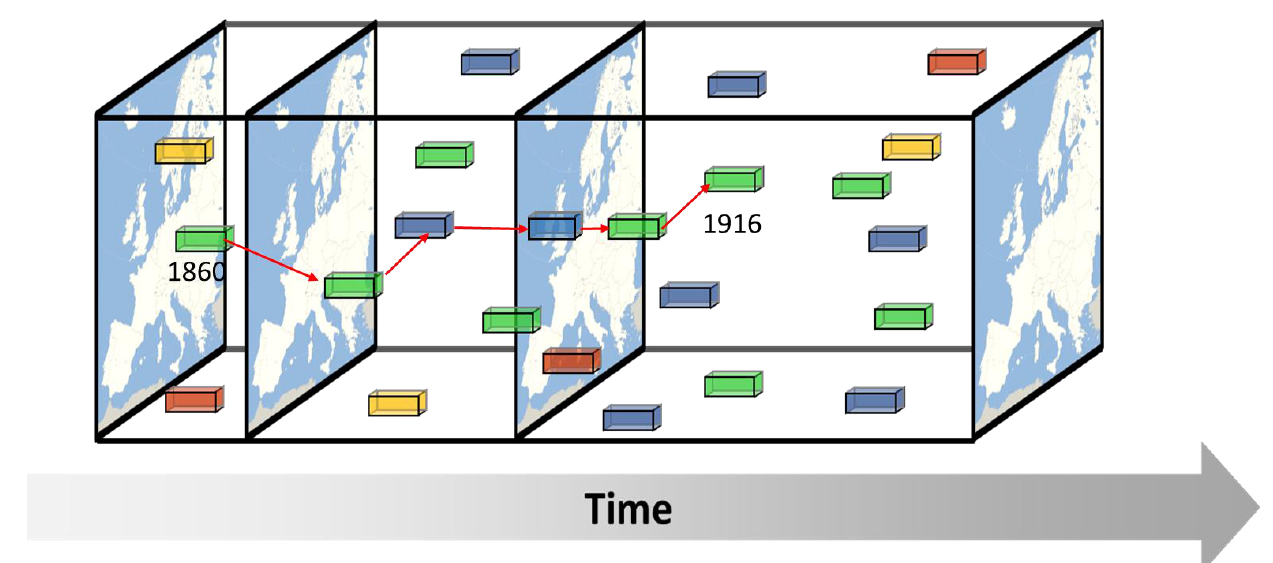
Figure 16. Authoring location-based narrative in MOP.